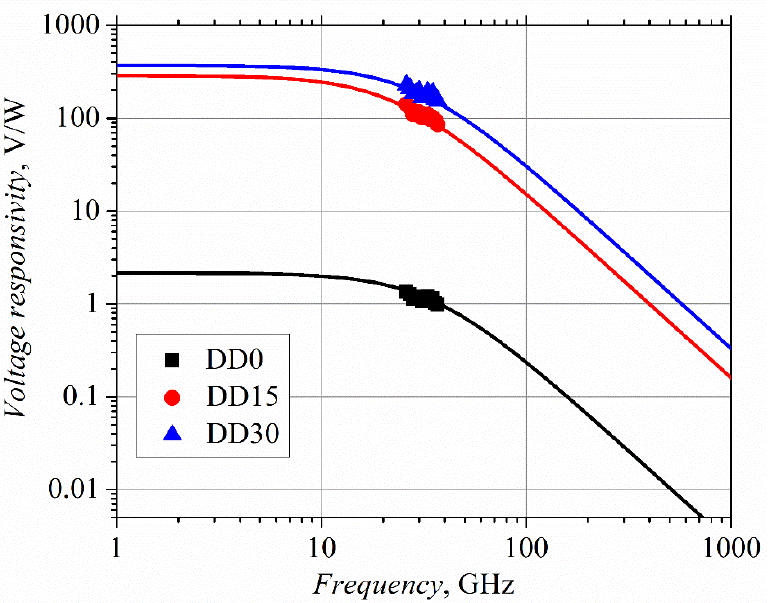
Figure 6. Experimental frequency dependence of voltage responsivity of the planar microwave diodes (dots) in the K a frequency range. Solid lines mark the dependences in wider frequency range calculated using Equation (4).